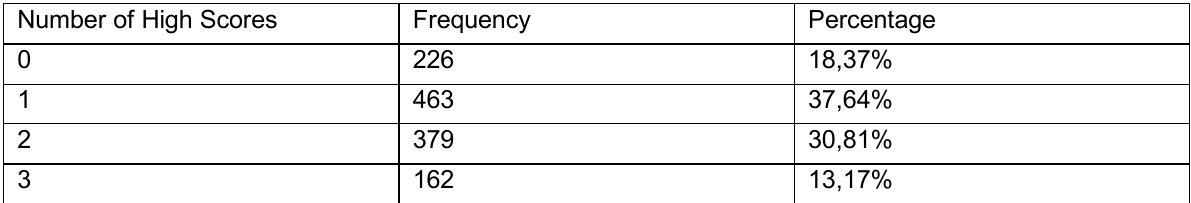
Table 4: Frequency Distribution of The Number of High Scores of The Respondents Number of High Scores Frequency Percentage